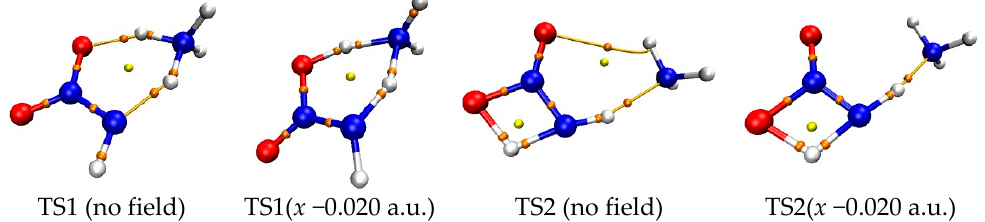
Figure 2. Selected bond critical point (BCP) of AIM in TS1 and TS2.